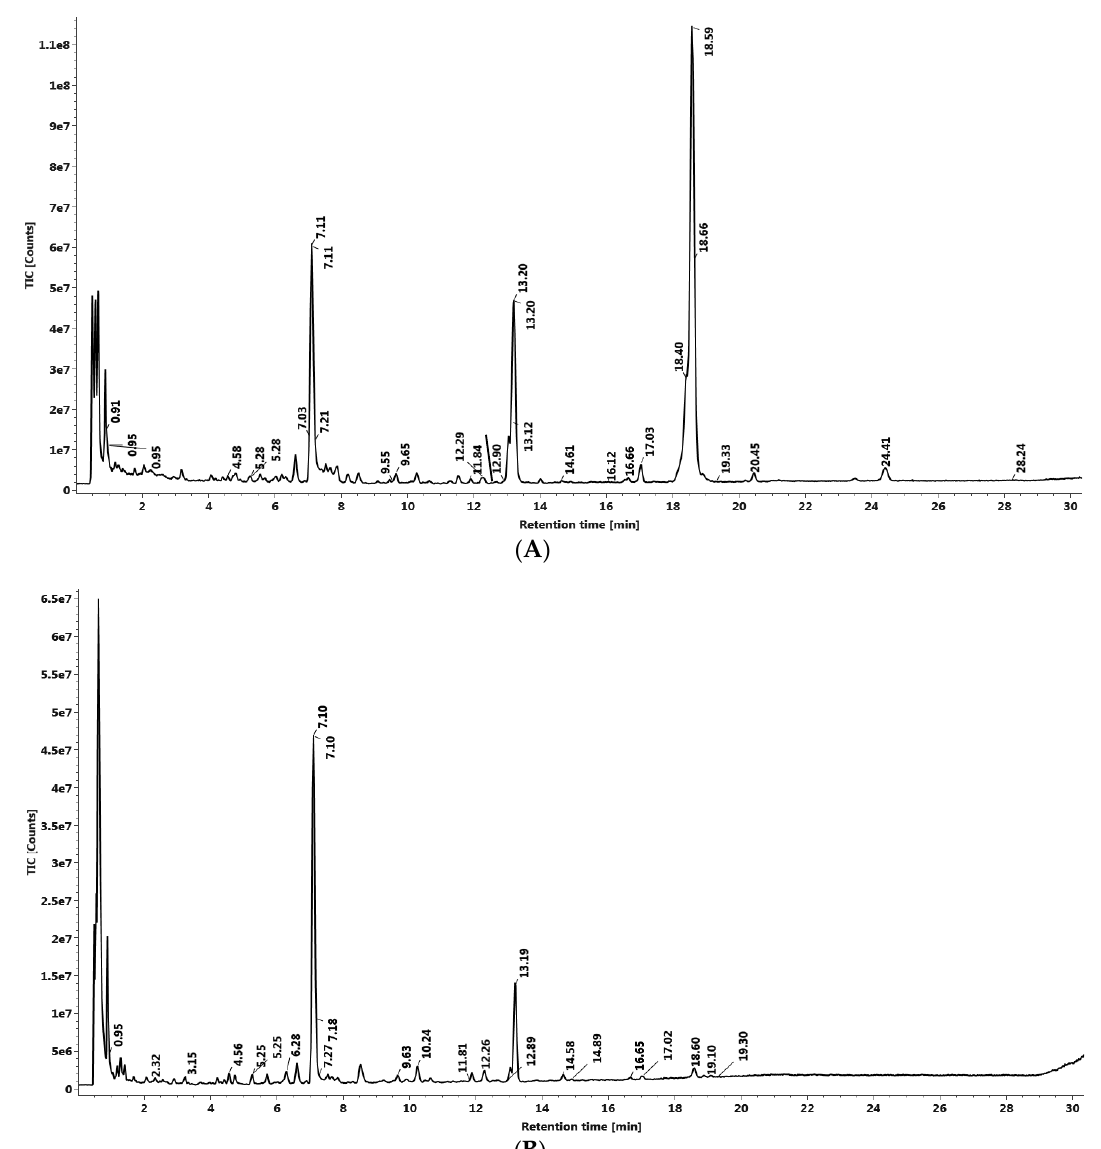
Figure 3. ( A ) UPLC–MS QTof Chromatograph of Gloriosa seed extract in the positive mode. ( B )UPLC–MS QTof Chromatograph of Gloriosa seed extract in the negative mode. Table 2. UPLC–MS QTof identified compounds of the Gloriosa superba seed in the positive and the negative mode.